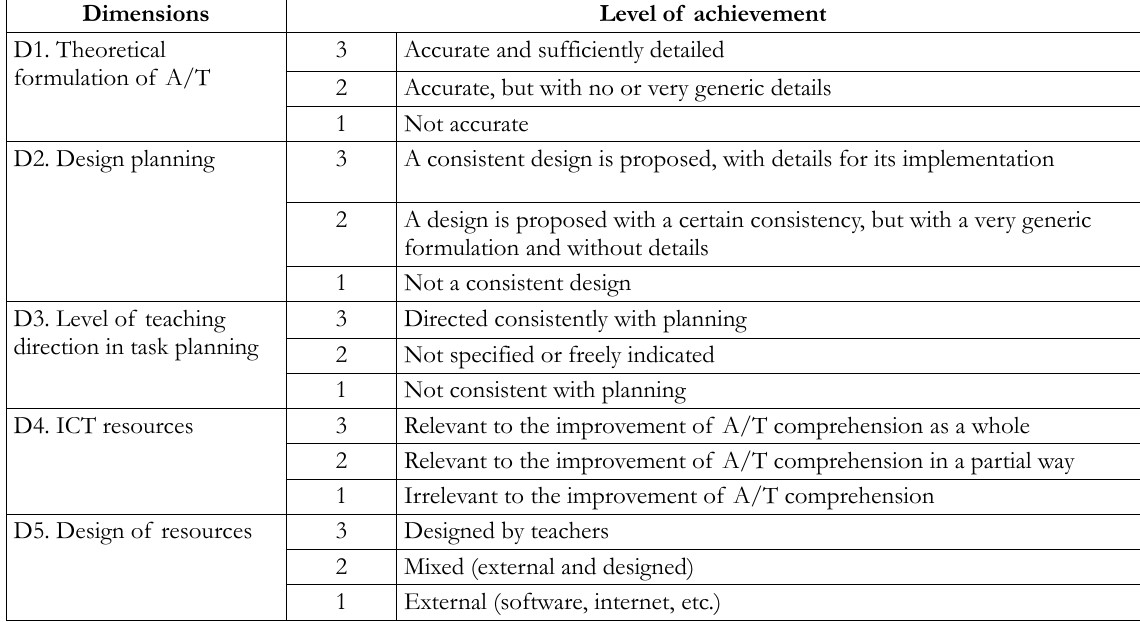
Table 6. Dimensions analyzed in the final